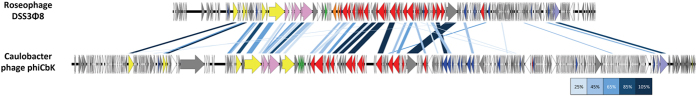
Genome wide comparison between roseophage DSS3Φ8 and Caulobacter phage phiCbK.White arrows represent ORFs for which no putative function can be attributed. Yellow, green, red and purple arrows represent structure, lysis, replication and packaging ORFs, respectively. Pink arrows stand for GTA structure, while orange arrows represent prophage-related ORFs. Grey color stands for hypothetical proteins. Related genes of these two phages are connected by blue shading. The color box corresponds to different amino acid identities.